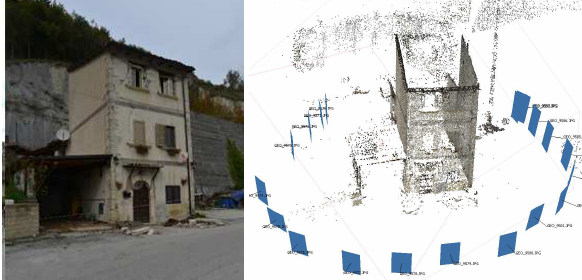
Figure 3. A series of terrestrial images and close-range cameras